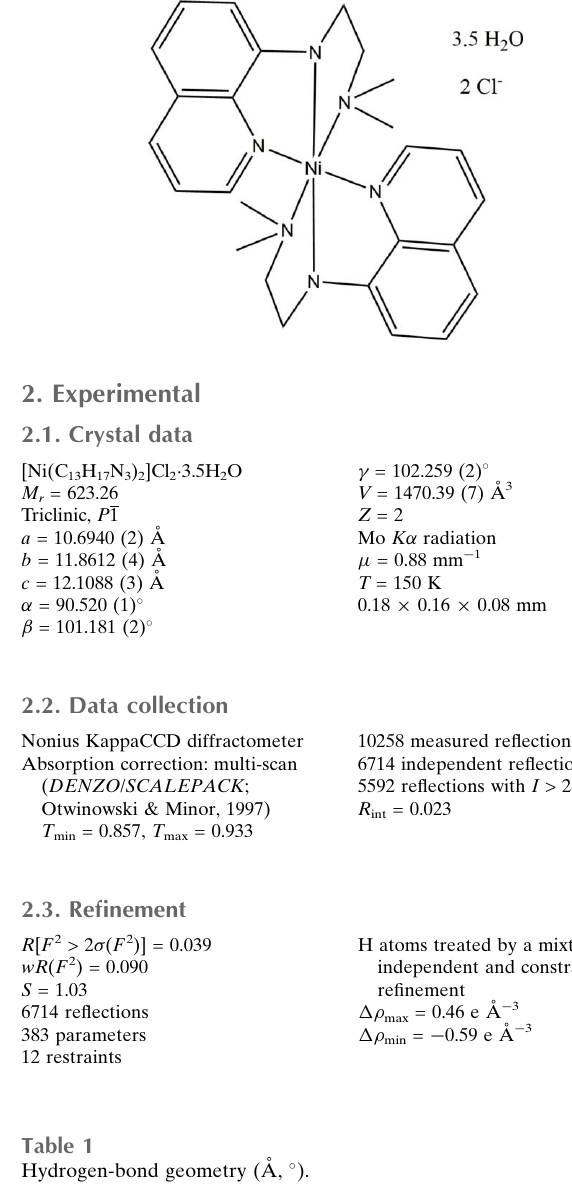
Hydrogen-bond geometry (A˚ , (cid:3) ). D —H (cid:2)(cid:2)(cid:2) A D —H H (cid:2)(cid:2)(cid:2)